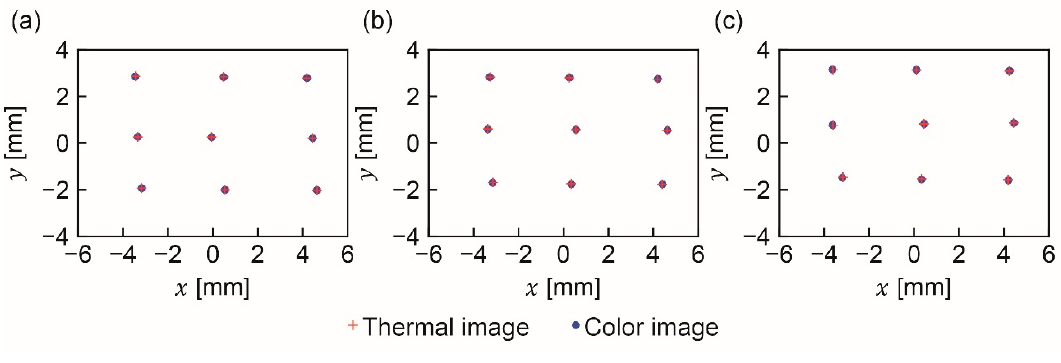
Figure A7. Positions of the light source at distances of ( a ) 0.5, ( b ) 1, and ( c ) 2 m on captured color images and mapped thermal images. The mapping was estimated using pairs of images of the light source at a distance of 0.5 m.